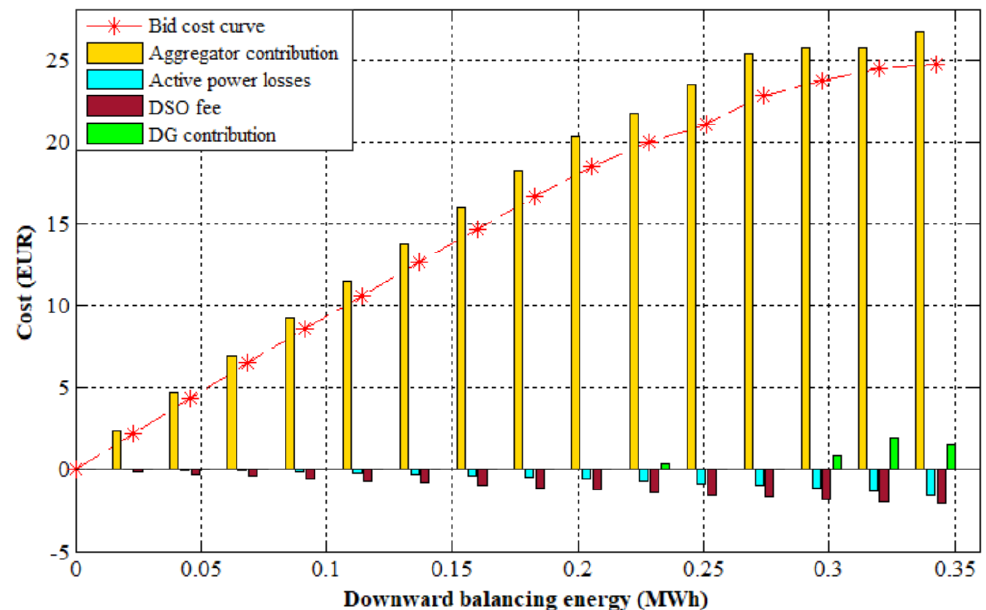
Figure 6. Aggregated price/quantity curve as a function of downward balancing